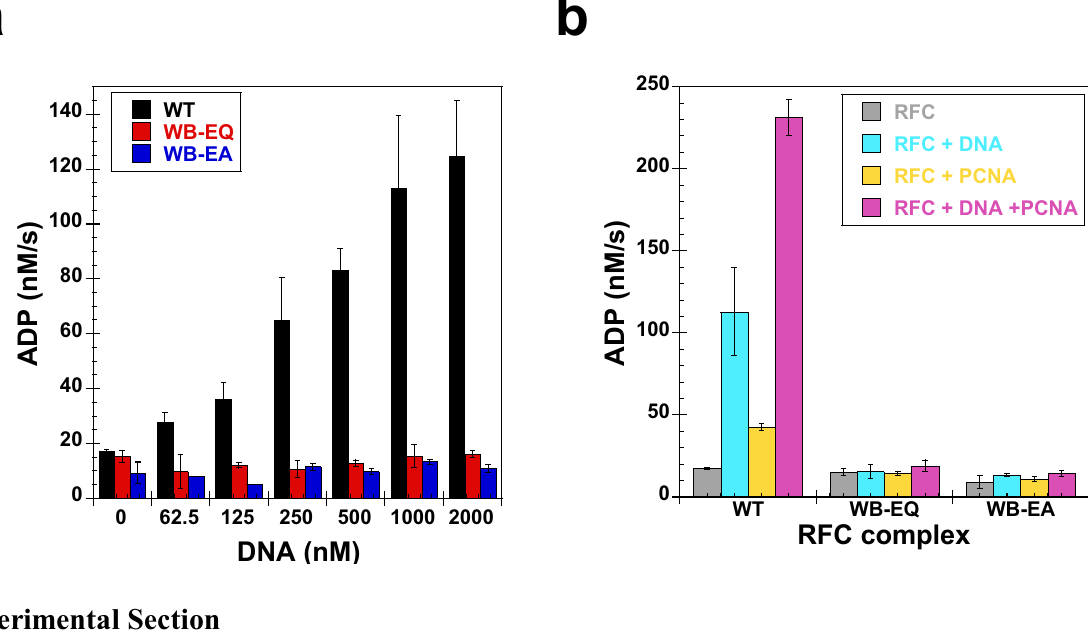
Figure 6. Effects of Walker B glutamate mutations on rates of ATP hydrolysis. ( a ) Rates of ATP hydrolysis were measured for WT RFC (black), the WB-EQ mutant (red) and the WB-EA mutant (blue) in the presence of 0.5 mM ATP and varying concentration of p/t DNA. The concentration of ATP hydrolyzed per second is plotted at several DNA concentrations for solutions containing 450 nM each RFC. ( b ) Rates of ATP hydrolysis were measured in assays containing 1 µM PCNA in the absence (yellow bars) and presence (magenta bars) of 1 µM DNA. Data from RFC alone (gray bars) and RFC with 1 µM DNA (cyan bars) are taken from panel a. Data shown are the average of three independent experiments. Error bars represent standard